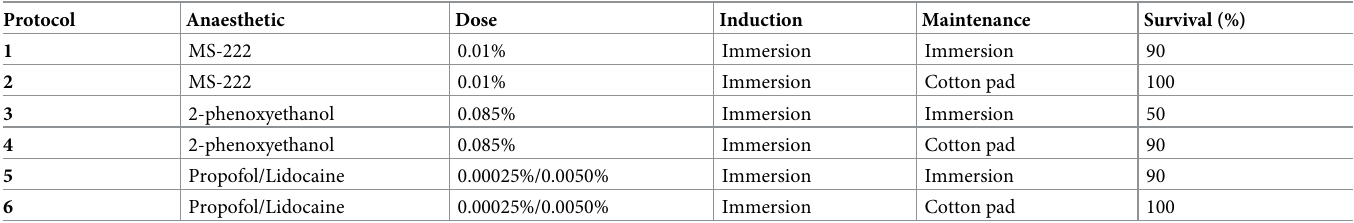
Table 3. Protocol numbers and the corresponding procedures with survival